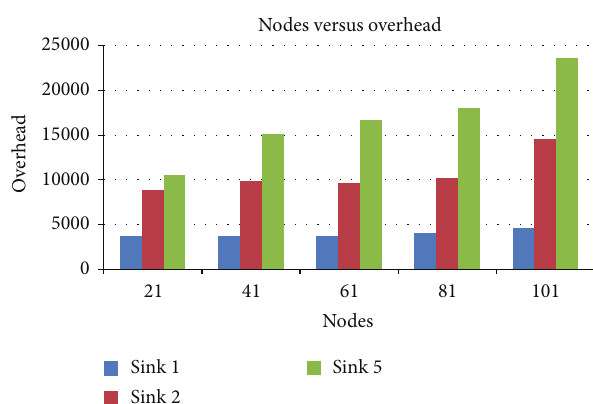
Figure 7: Nodes versus overhead in terms of